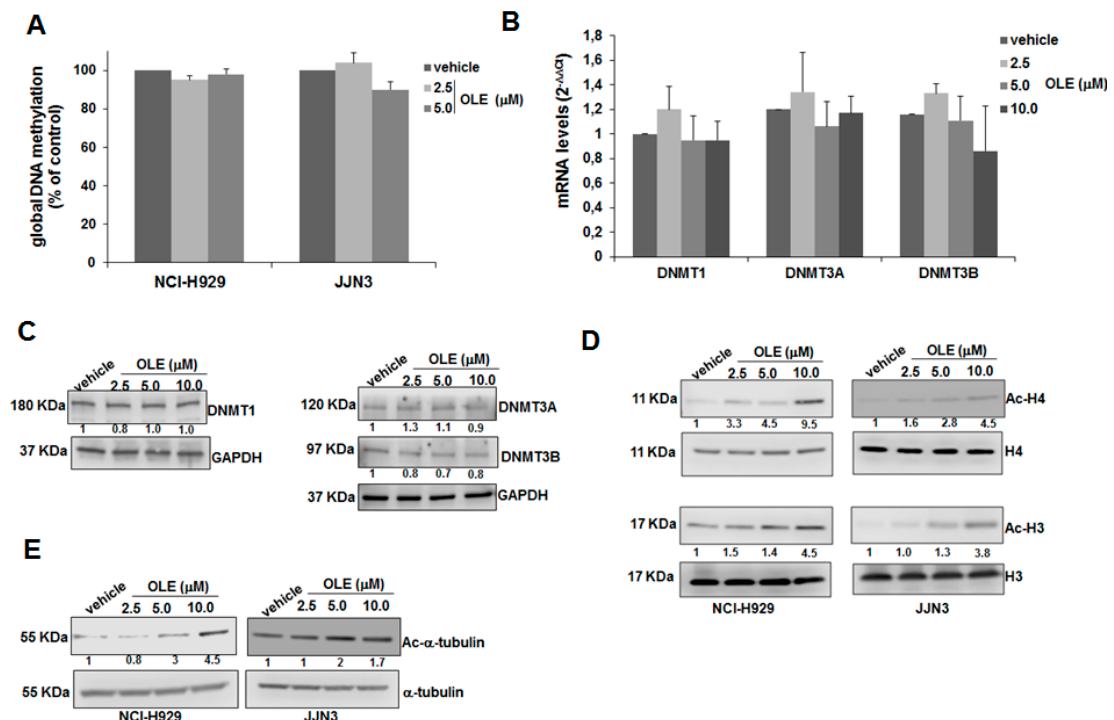
Figure 3. Oleacein affects the acetylome but not the methylome of MM cells. ( A ) Global DNA methylation was measured in MM cells treated for 24 hours with oleacein, as reported in materials and methods. Quantitative Real Time PCR (QRT-PCR) ( B ) and WB analysis ( C ) of DNMT1, DNMT3A and DNMT3B in JJN3 cells treated for 24 hours with oleacein; GAPDH was used as loading control. WB analysis of acetylated histone H3, histone H3, acetylated histone H4, histone H4 ( D ) and acetylated α -tubulin ( E ) in NCI-H929 and JJN3 cells treated with oleacein for 24 hours; GAPDH was used as loading control.